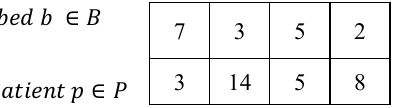
Fig. 3. Graphical representation of a